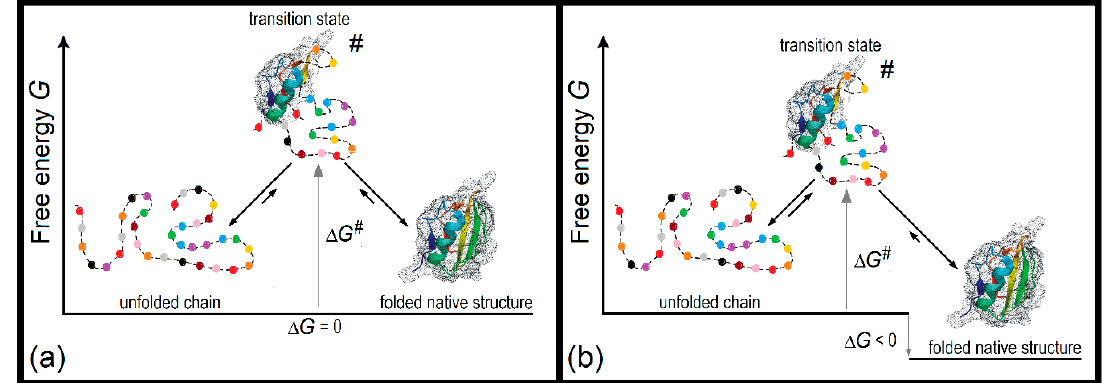
Figure 2. A schematic view of a sequential reversible folding–unfolding pathway of a globular protein [50,51]. At each step in the direction of folding, an unfolded residue joins the growing native structure. The native-like part (shaded) of semi-folded intermediates on the fast folding–unfolding pathway should be compact, i.e., the boundary separating unfolded (depicted with the broken line), and native phases should be minimal. The free energies of natively folded, unfolded, and transition states, which determine the folding/unfolding rates, depend on ambient conditions, but, being functions of the states, they are independent of how protein arrives at these states. ∆ G # , the transition state free energy (i.e., that of the nucleation of the folded structure) is counted off that of the initial unfolded state; it corresponds to the maximal free energy on the fastest folding–unfolding pathway. ( a ) The mid-transition case: Equal stabilities of the unfolded and native states (i.e., Δ G = 0) maintain dynamic (50%:50%) equilibrium between them. ( b ) The in-water case: The native state is more stable than the unfolded one (i.e., Δ G < 0), and therefore all or nearly all protein molecules obtain their folded native state. Adapted from [52] with some modifications.